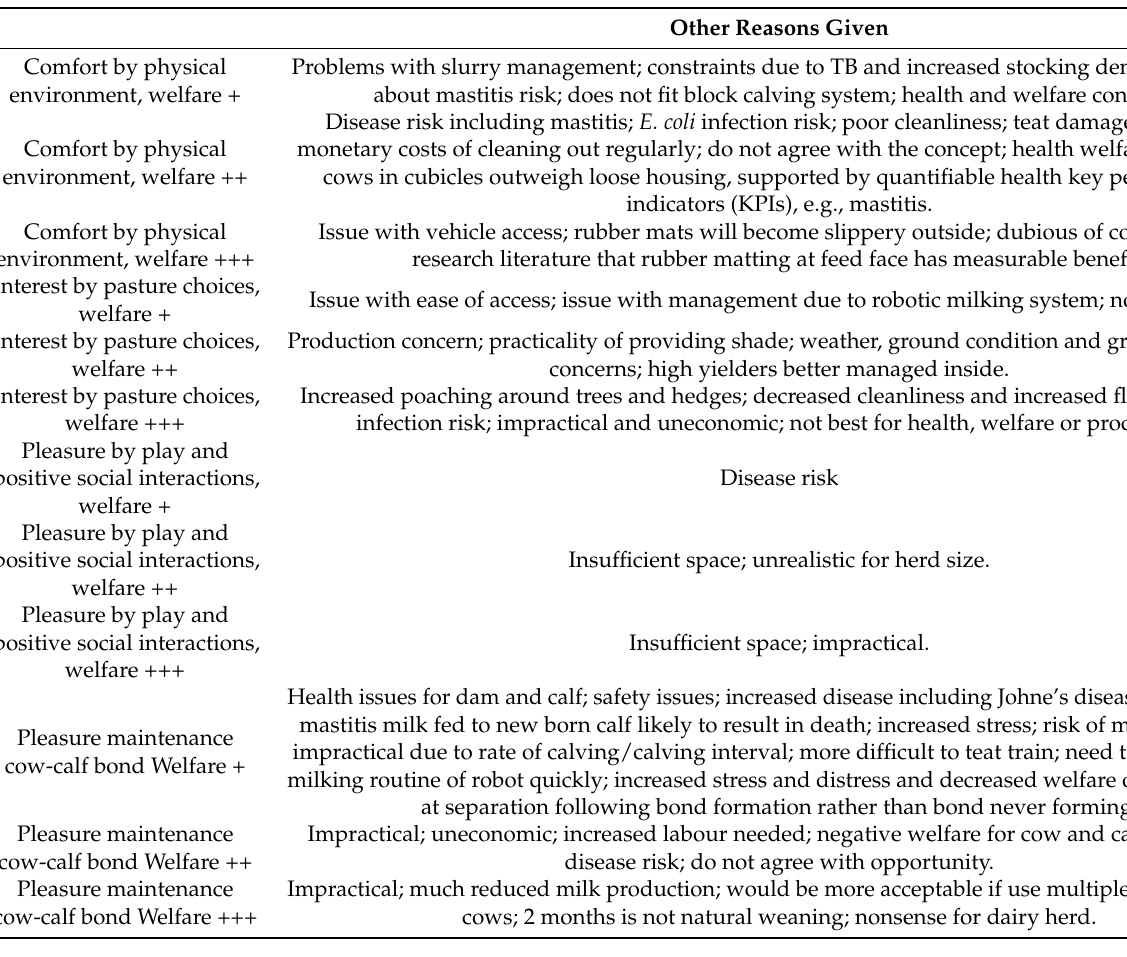
Table 5. Other reasons reported by farmers for not achieving each welfare level for each positive welfare opportunity.